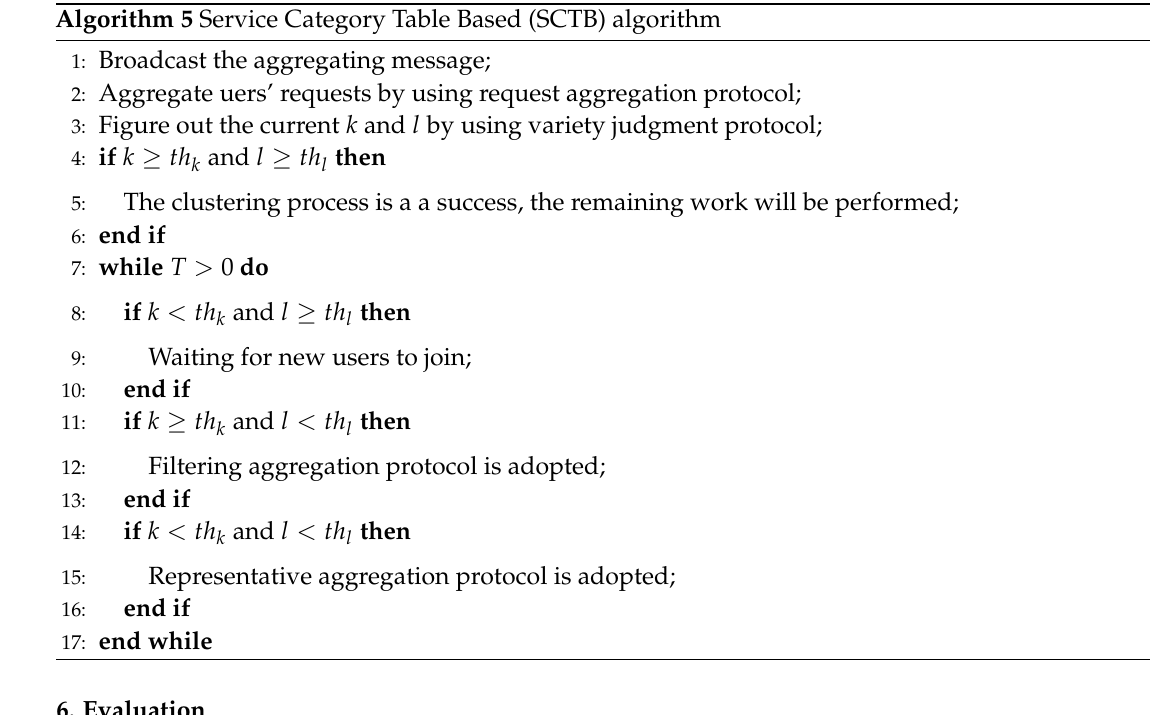
Algorithm 5 Service Category Table Based (SCTB)